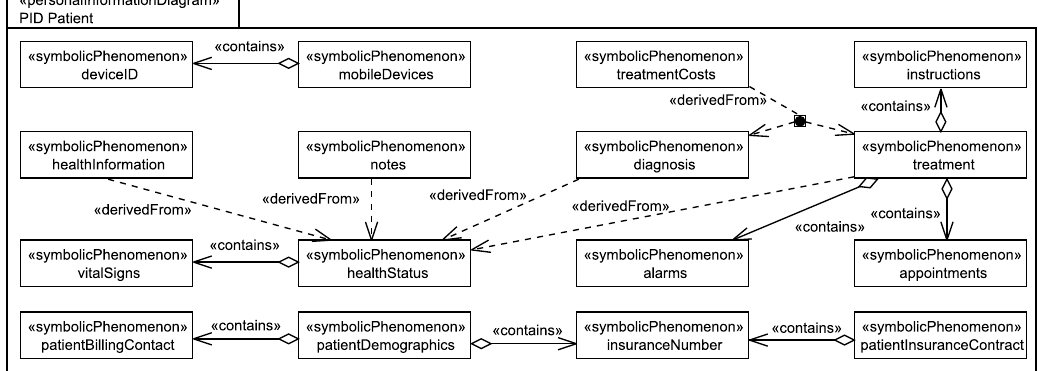
Figure 8. View on the final personal information diagram for the patient showing the personal information of the patient and the relations between this personal